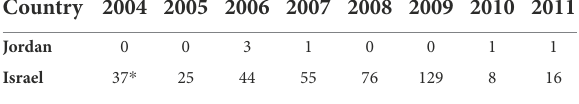
TABLE 3 Number of attacks in Jordan and Israel per